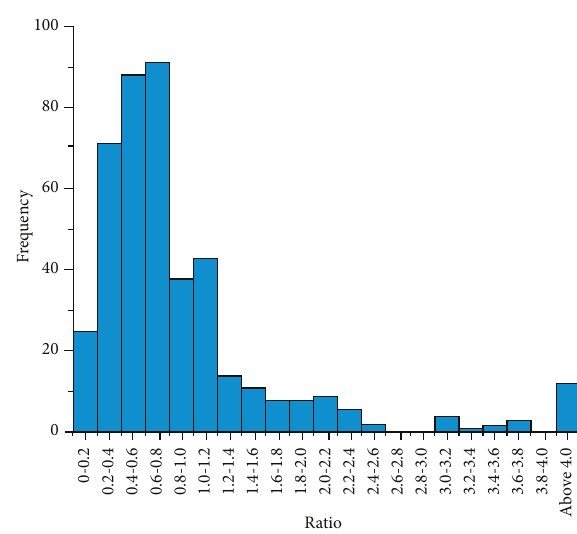
Figure 3: Histogram of the ratio of the ridership during COVID-19 to the ridership before